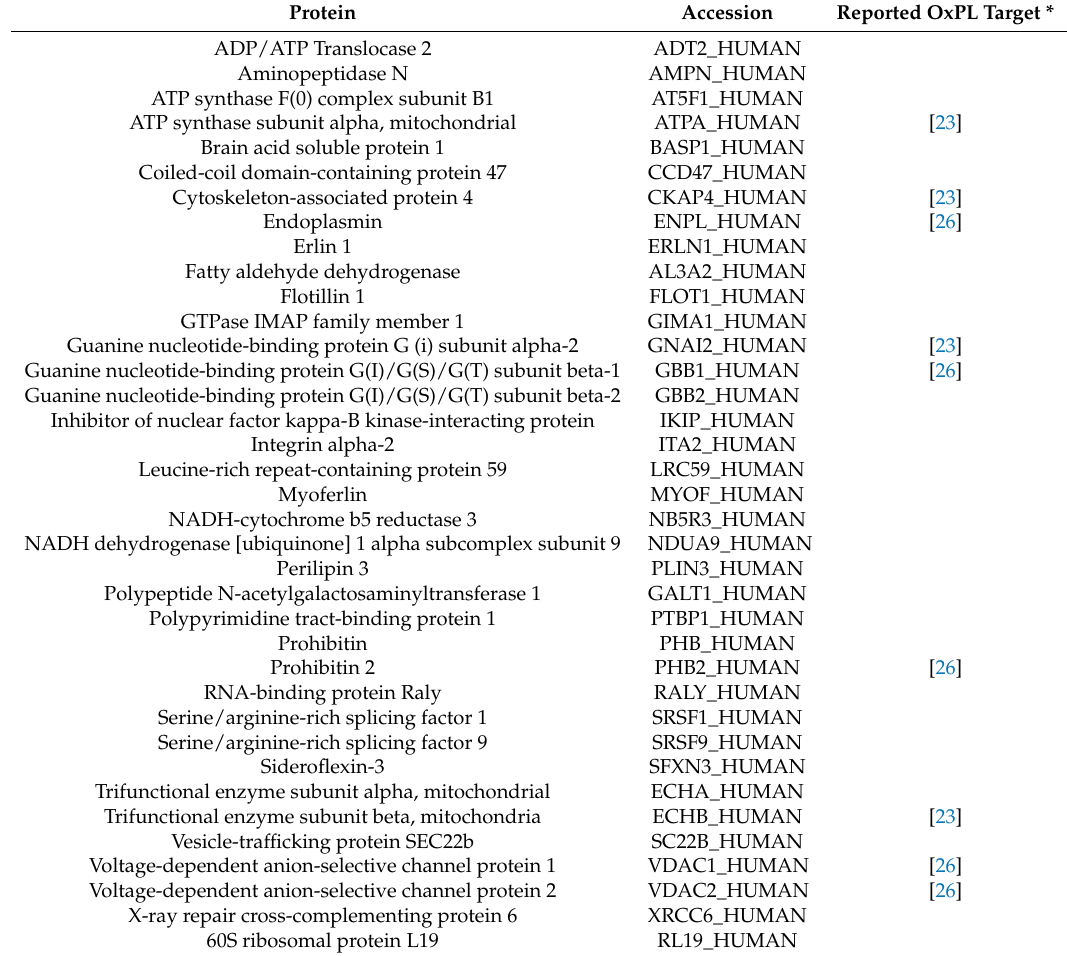
Table 2. Potential OxPAPC target proteins identified from the PBS-insoluble/RIPA-soluble